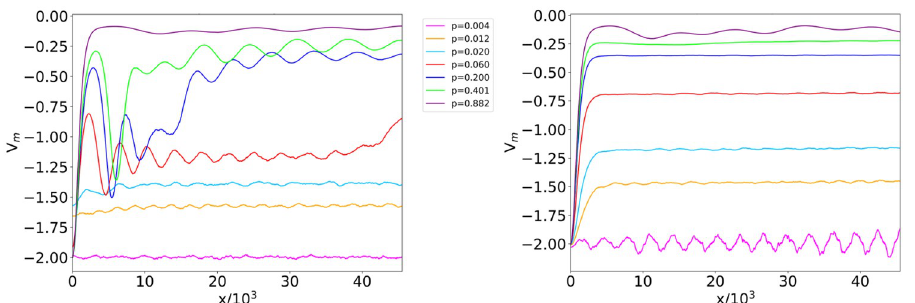
Fig 3. WS ensemble potential at different ( c , p rew ) parameter configurations. Ensemble potentials V m computed over 100 WS networks with N = 500 nodes and rewiring probabilities p comparison with the analogous ensemble potentials in the ER network model [31], plots are labeled using the equivalent connection probability p , related with the average degree c as p = c /( N − 1).